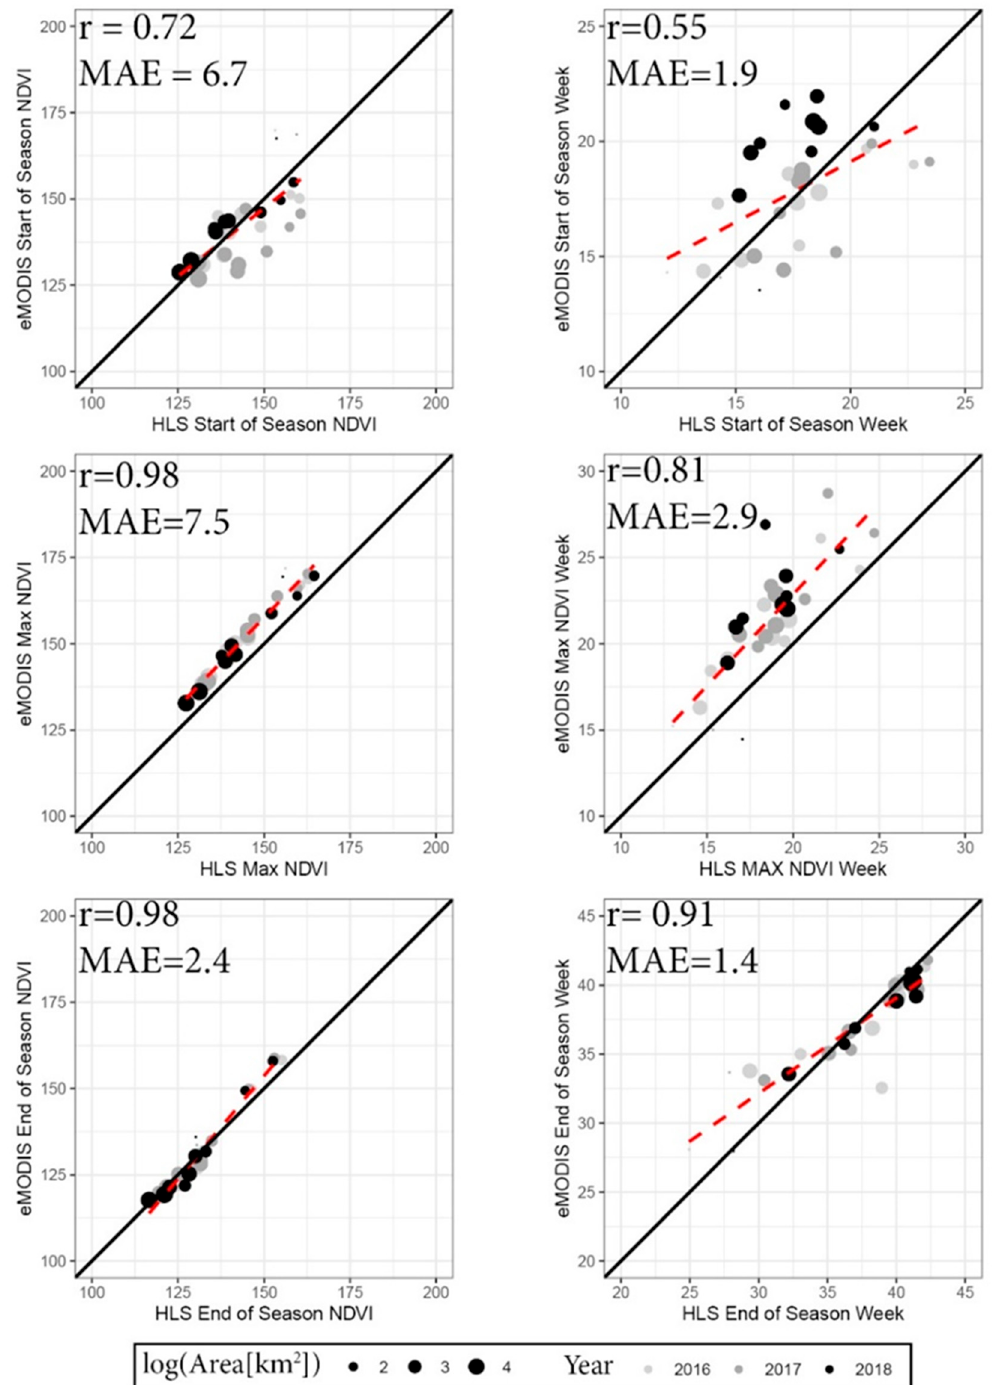
Figure 4. Mean satellite-derived phenophase metrics and associated Normalized Difference Vegetation Index (NDVI) for rangelands stratified by level III ecoregions [28] over the 2016–2018 record. Phenometrics are summarized for homogeneous pixels (coefficient of variation <20%), as calculated from standard deviation and mean focal scans (9 × 9 pixels) of the average 30-m growing season NDVI, as estimated from regression tree models. Pearson’s correlation coefficient ( r ) and mean absolute error (MAE) are shown for all years combined. Data were fit using ordinary least-squares regression (dashed line) and the 1:1 line is shown as a solid black line. NDVI is scaled (100× + 100) to an 8-bit unsigned integer.